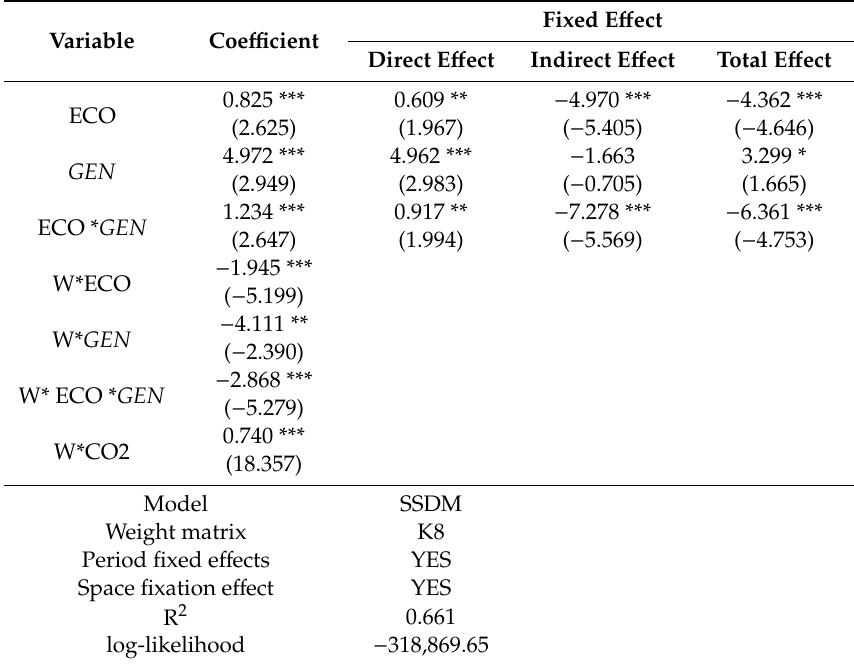
Table 7. Impact of ECO on carbon emissions: National